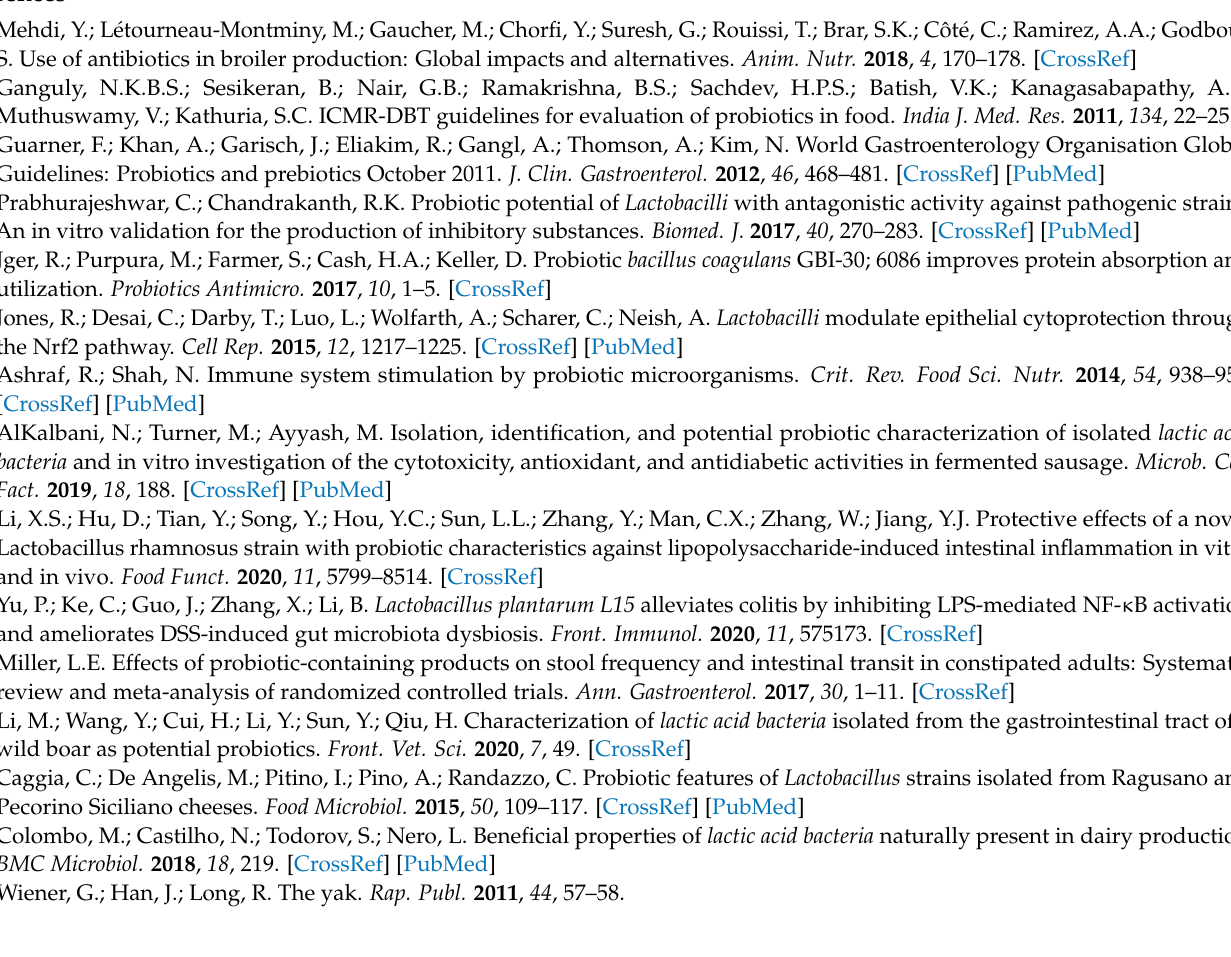
Figure S3: Phylogenetic tree of